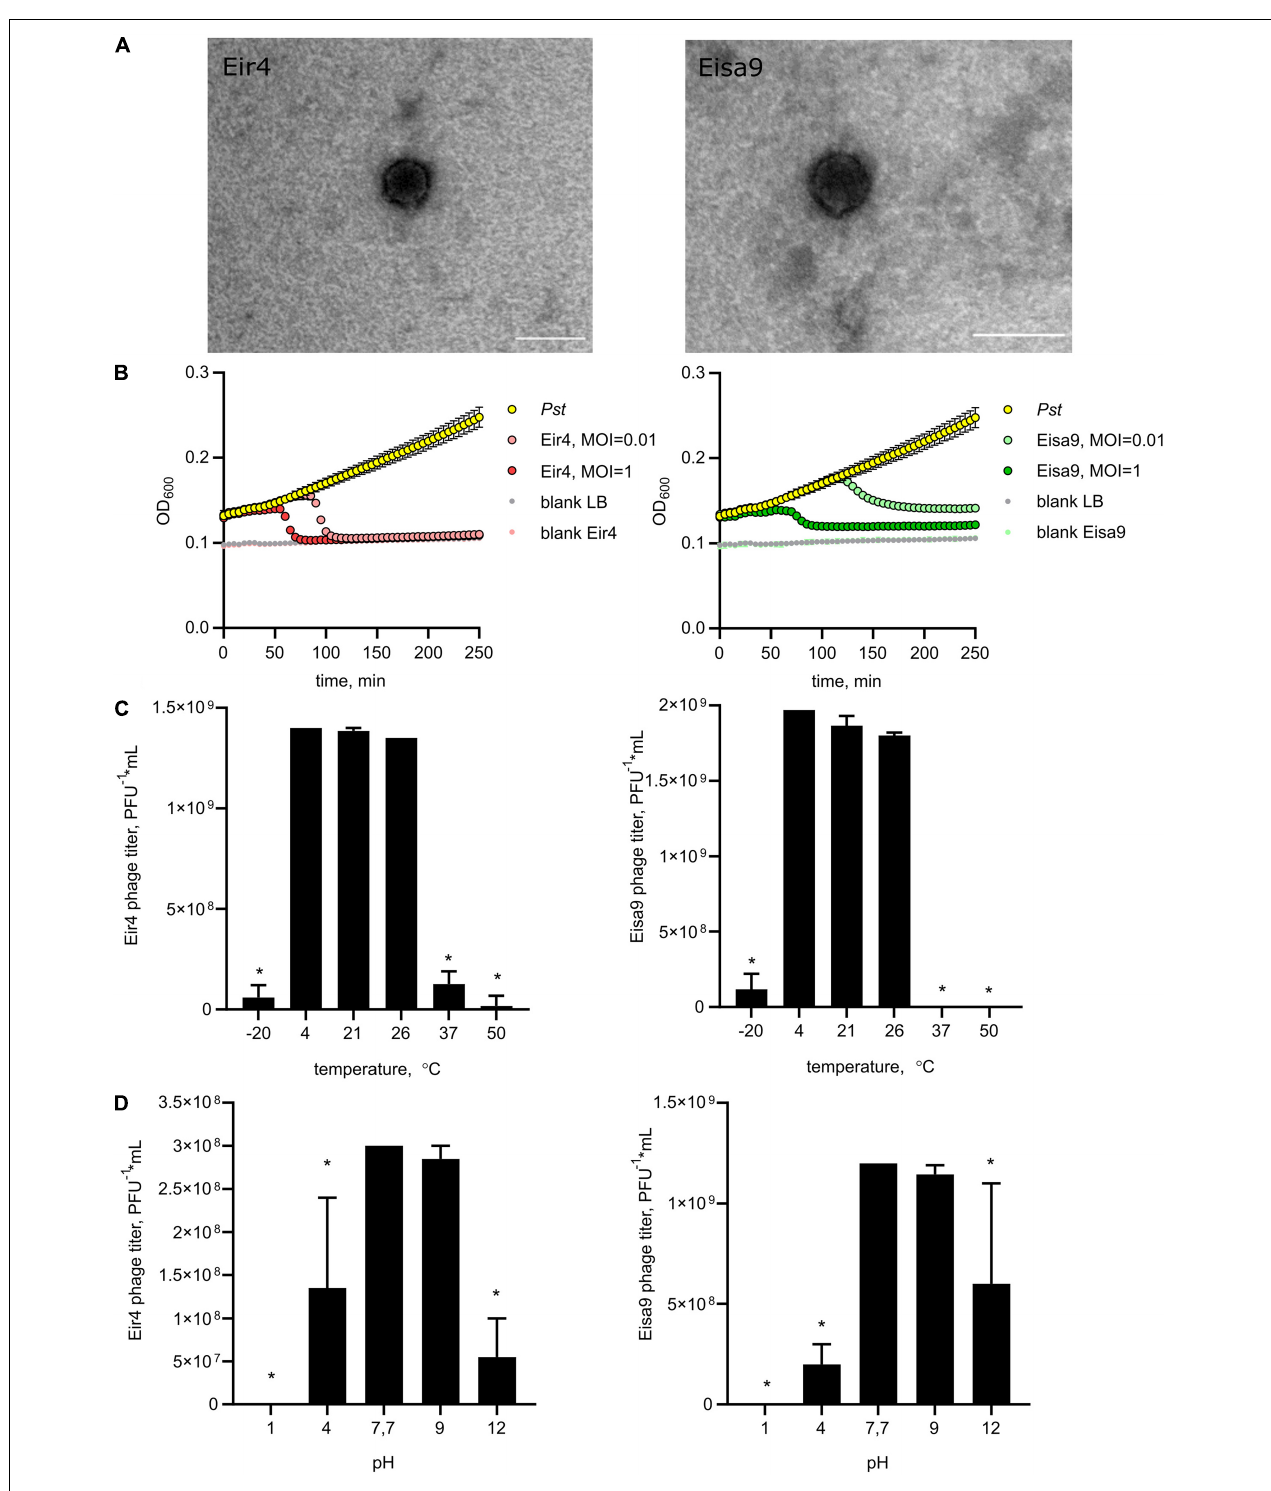
FIGURE 1 | Morphology and biological properties of newly isolated phages of P. syringae pv. tomato , Eir4 (left panels) and Eisa9 (right panels). (A) Capsid morphology, transmission electron microscopy, scale bar = 100 nm. (B) Individual in vitro lysis kinetics for Eir4 and Eisa9 at an MOI of 0.01 or 1 on the Pst strain DC3000. Each value is the average from three different cultures ± standard deviation. (C) Temperature stability of phages. (D) pH stability of phages. Temperature stability tests were performed at pH = 7.7, and pH stability tests were performed at t = 4 ◦ C. Bar plots indicate the mean of two biological repeats + SEM; asterisks indicate statistically significant differences from values at t = 4 ◦ C (C) and pH = 7.7 (D) , Student’s t -test p < 0.05.